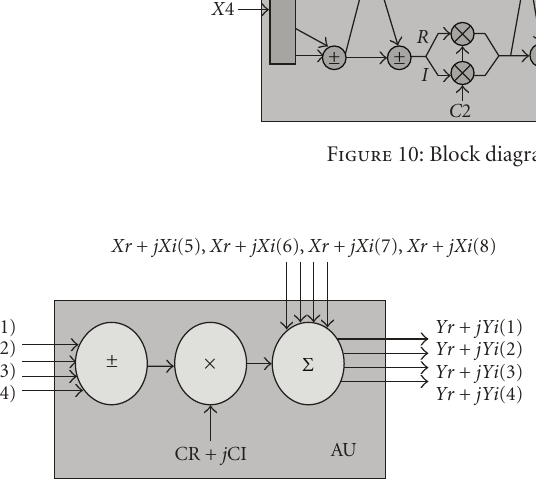
Figure 11: AU configuration for complex multiplication-acc- umulation.